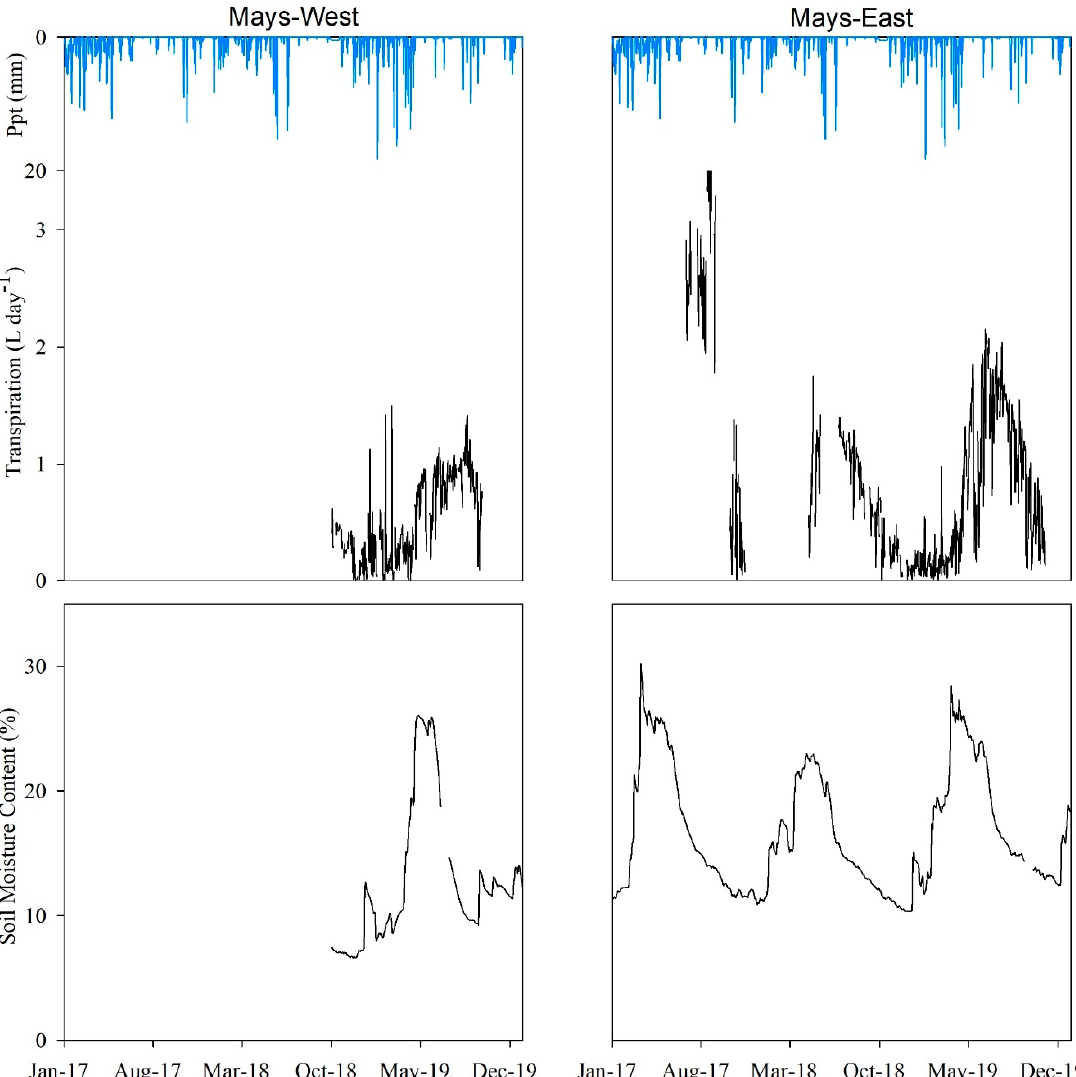
Figure 6. Juniper sapling daily averaged transpiration rates and soil moisture content, 0 to 0.8 m ( θ tot ) in response to precipitation (Ppt) inputs in the Mays-West and Mays-East monitoring locations at Mays WS.